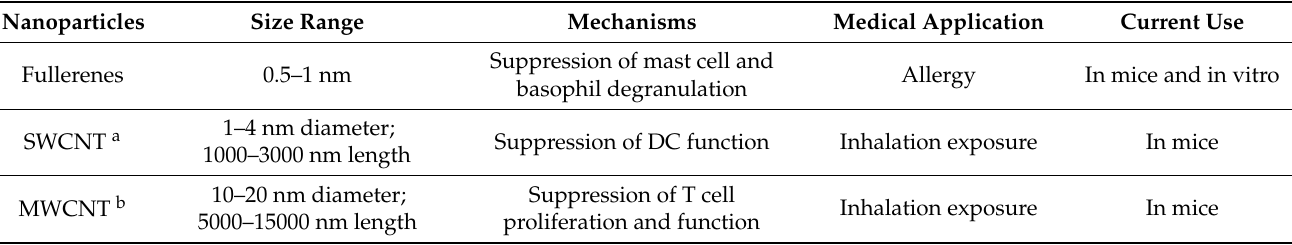
Table 4. The immunosuppressive effects of some